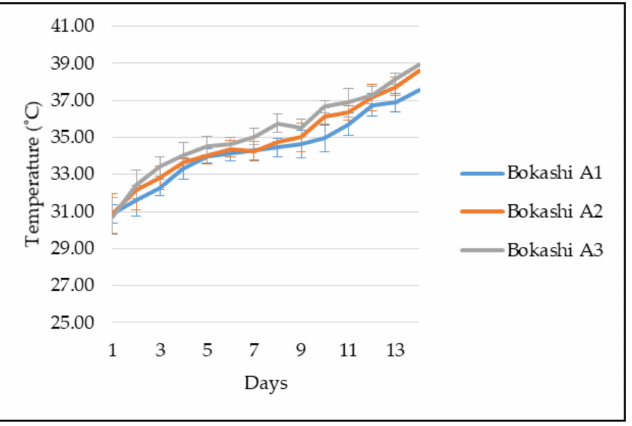
Figure 6. The observation of the temperature of different types of bokashi from day 1 to day 14.